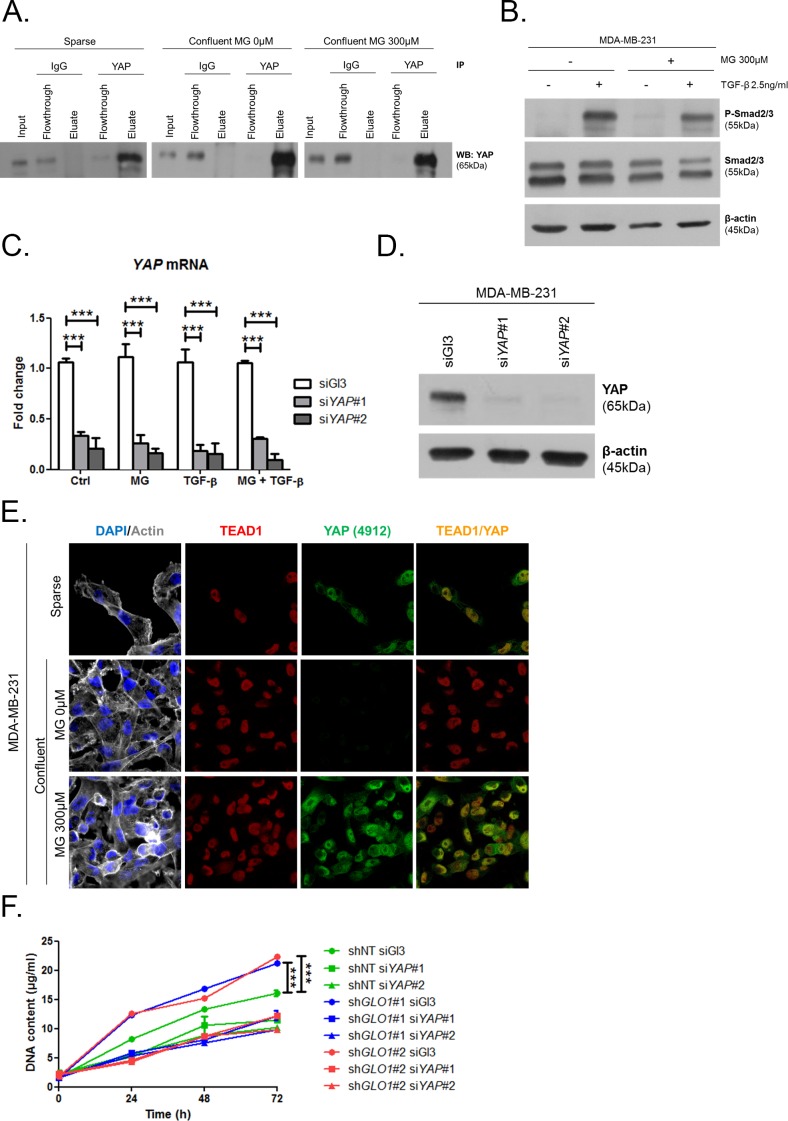
MG induces YAP co-transcriptional activity in breast cancer cells.(A) Western blot detection of YAP in MDA-MB-231 cells under the indication conditions. Immunoblot is representative of three independent experiments. (B) Western blot of Phospho-Smad2/3 and Smad2/3 in MDA-MB-231 treated with MG until confluence and then with TGF-β during 2 hr. β-actin is used for normalization. (C and D) YAP mRNA and protein level assessed by qRT-PCR and Western blot, respectively, in MDA-MB-231 cells silenced for YAP (siYAP#1 and #2) and treated in the same conditions as in Figure 5D. Data were analyzed using two-way ANOVA followed by Bonferroni post-test and shown as the mean values ± SEM of three independent experiments. (E) YAP (Cell Signaling, 4912) and TEAD1 IF co-localization in MDA-MB-231 cells cultured under low (Sparse) density used as positive control and in high-density cultured cells (Confluent) in presence of MG. Magnification 630x. Data are representative of two independent experiments. (F) Proliferation assay on GLO1-depleted MDA-MB-231 (shGLO1#1 and #2) silenced or not for YAP (siYAP#1 and #2) at different time points. Data (72 hr) were analyzed using two-way ANOVA followed by Bonferroni post-test and shown as the mean values ± SEM of three independent experiments. All immunoblots are representative of three independent experiments. ***p<0.001.